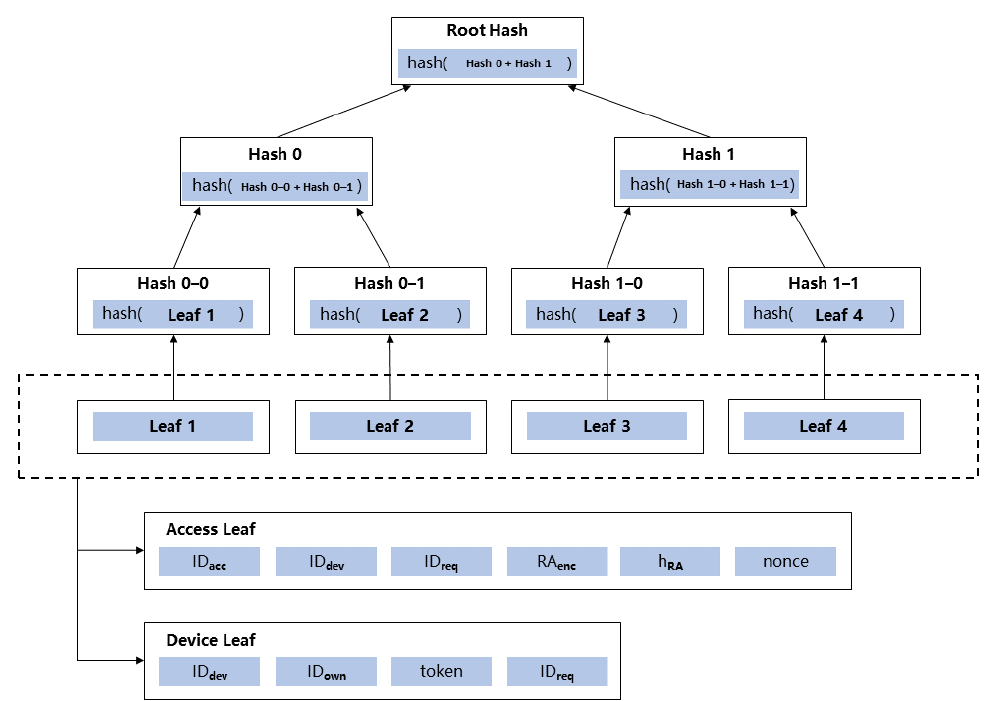
Figure 3. Two kinds of Merkle trees, “Access Merkle Tree” and “Device Merkle Tree”